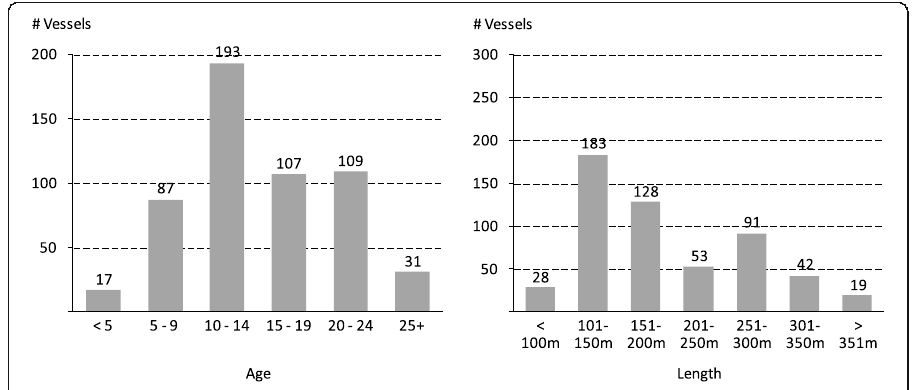
Fig. 4 Age distribution (left) and length distribution (right) of vessels in data. Source: Own